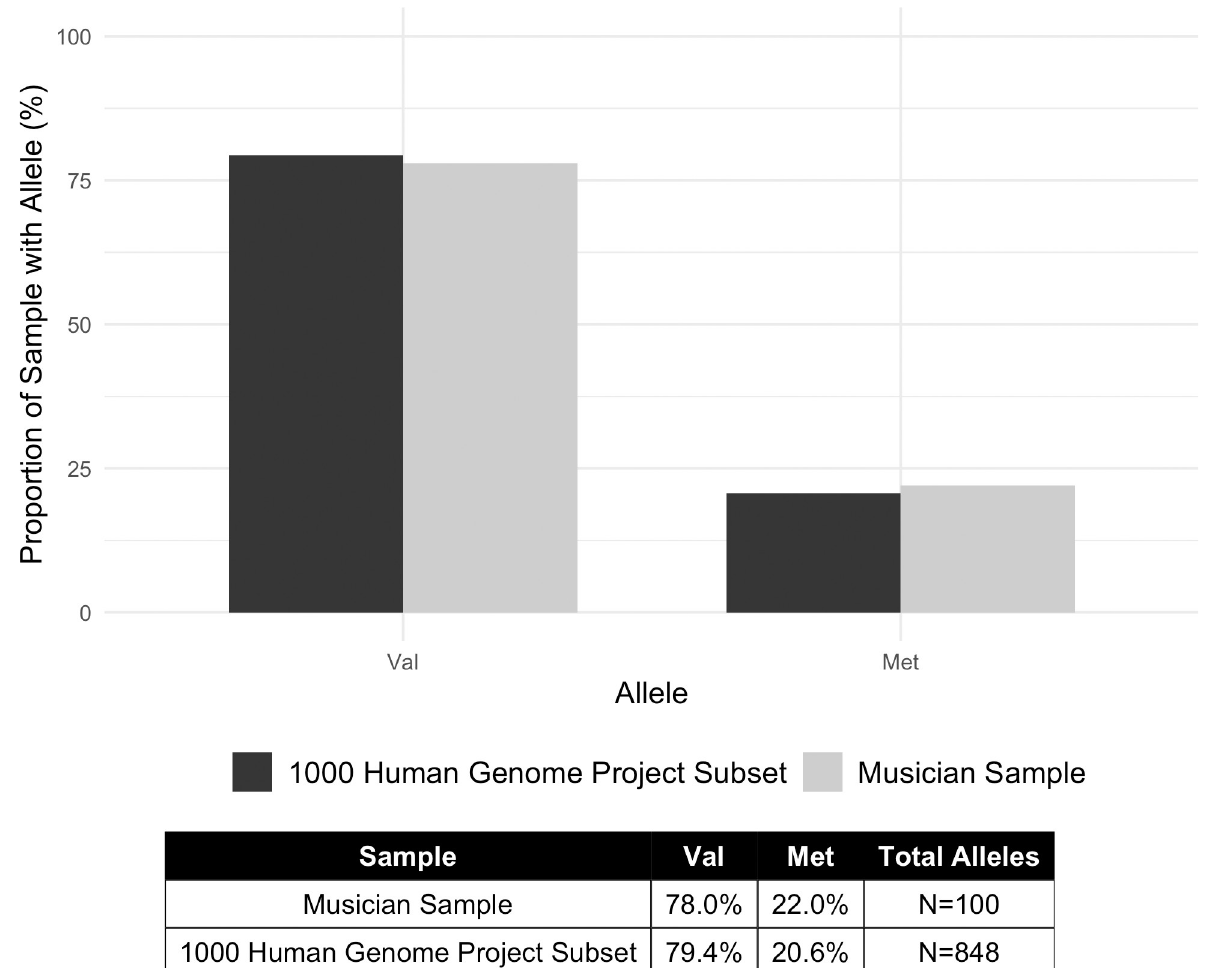
Fig 2. Allele frequency distributions in the musician sample and 1000 human genome project